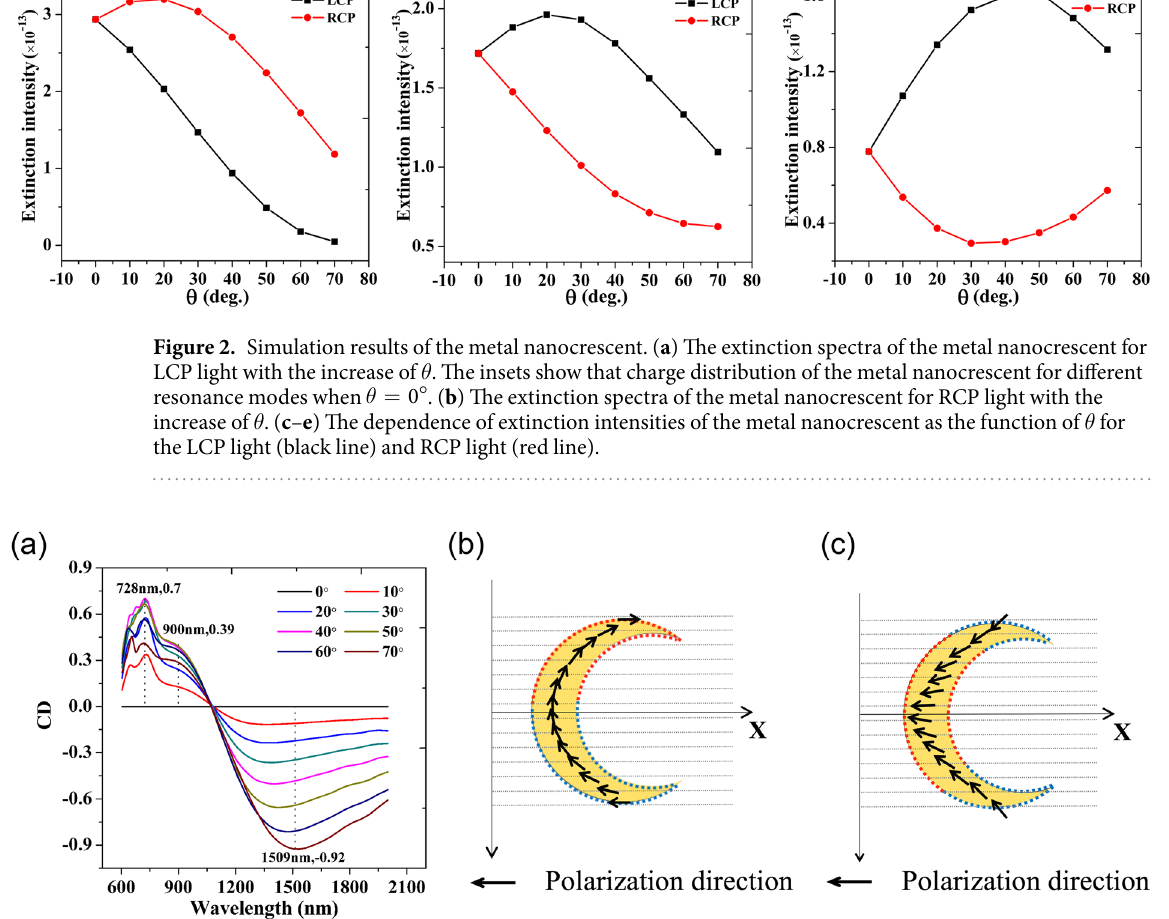
The CD coefficient can be calculated using the equation below.